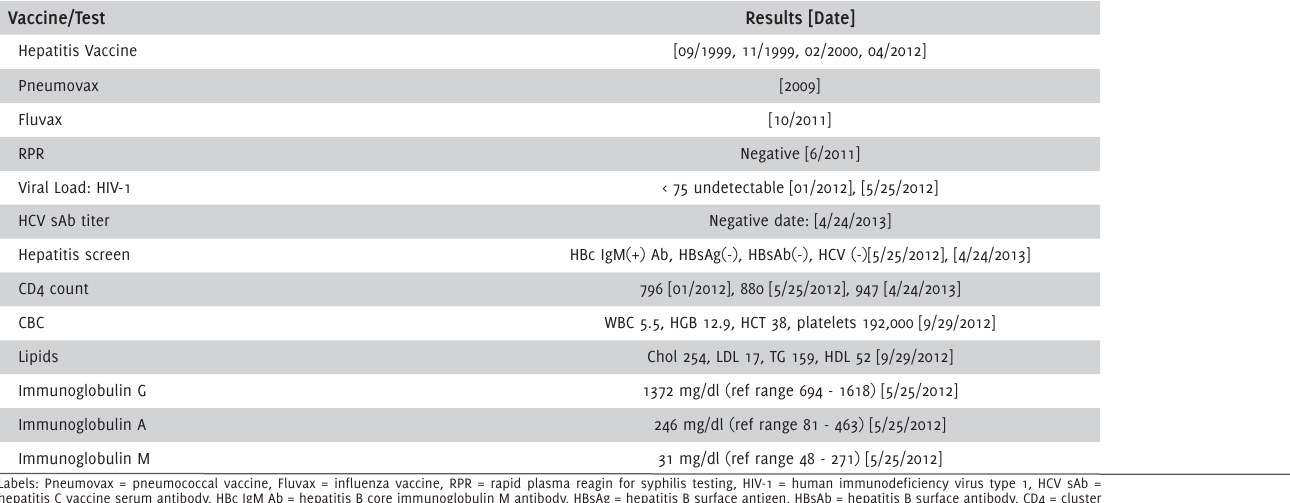
Table 1. HIV Patient Labs Showing Resistance to Hepatitis B Vaccine Hepatitis Vaccine